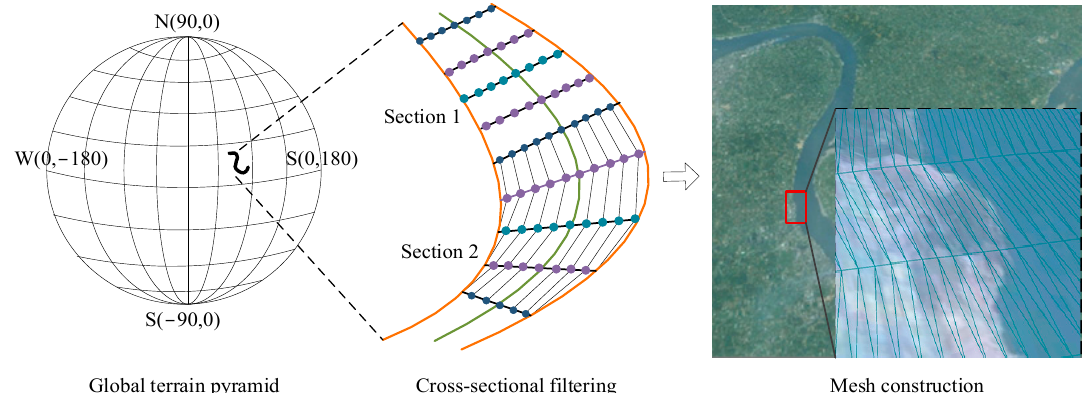
Figure 5. LOD-based surface mesh construction.